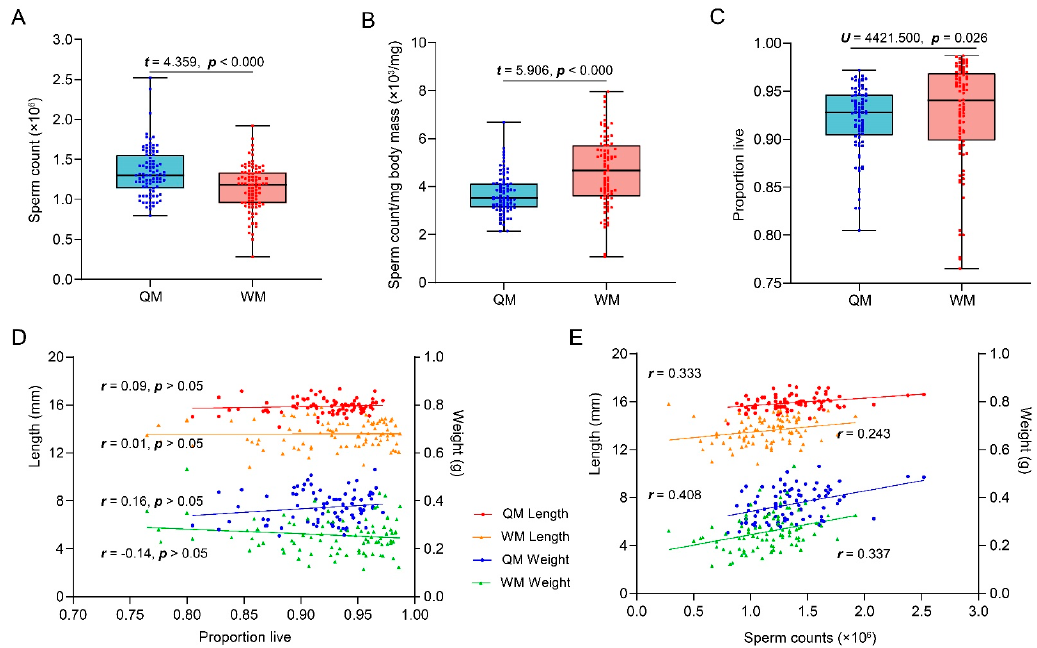
Figure 2. Comparison of sperm quantity, sperm quantity per mg body mass, sperm viability of the QMs and the WMs, and the correlation analysis between body size and sperm quality. ( A ) Sperm counts of the QMs and the WMs ( n = 84, 88); ( B ) sperm counts per mg body mass of the QMs and the WMs ( n = 84, 88); ( C ) the sperm viability of the QMs and the WMs ( n = 84, 88); ( D ) the correlation between sperm viability and body size of the QMs and the WMs; ( E ) the correlation between sperm counts and body size of the QMs and the WMs. A t -test was used to analyze whether significant differences existed in sperm counts and sperm counts per mg body size between QM and the WM. The Mann–Whitney U-test was used to analyze whether significant differences existed in sperm viability between the QM and the WM. Spearman rank correlation test was used to analyze the correlation between sperm viability and body size, Pearson correlation test was used to analyze the correlation between sperm counts and body size. The scatter bots represent the data values, and the lower edge lines of the box represent the upper quartile and the lower quartile in ( A – C ). The dots represent the data values in ( D , E